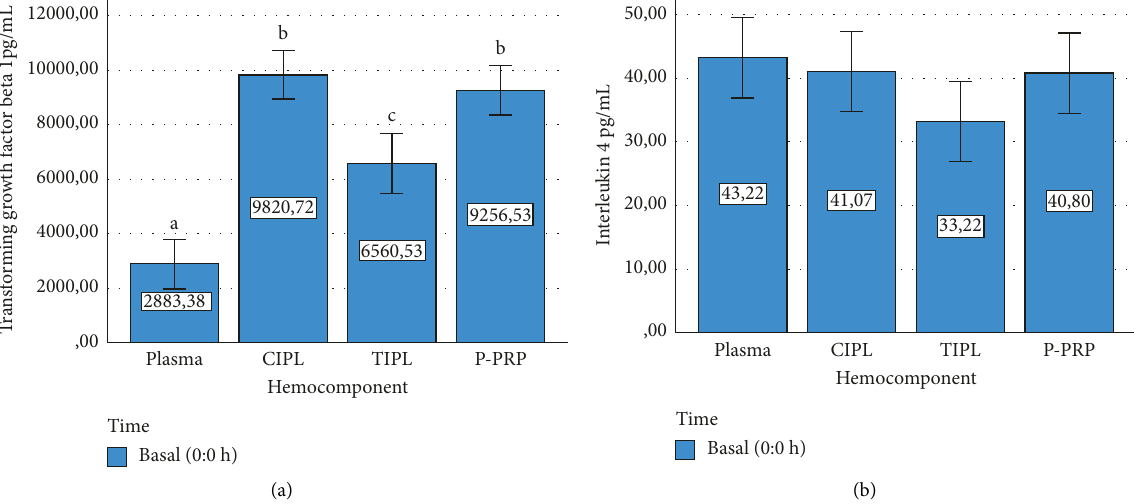
Figure 3: Mean ± sd basal mediator concentration in hemocomponents. (a) Transforming growth factor beta 1. (b) Interleukin 4. a–c Different lowercase letters denote significant ( P < 0 . 001) differences between the hemocomponents by the Games–Howell post hoc